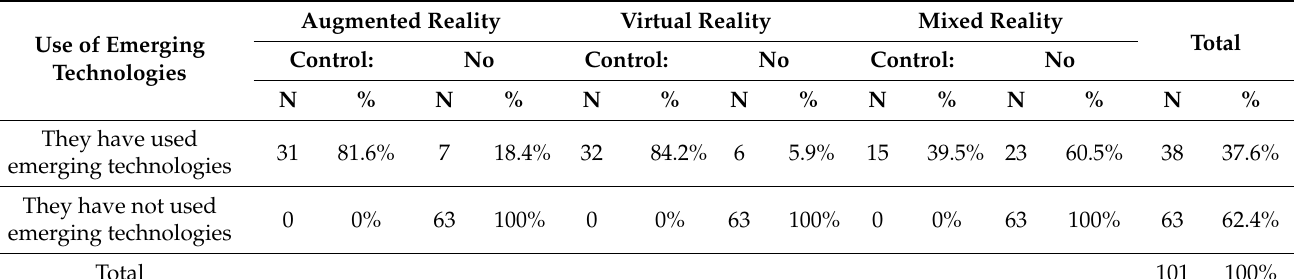
Table 4. Type of Emerging Technology by use.